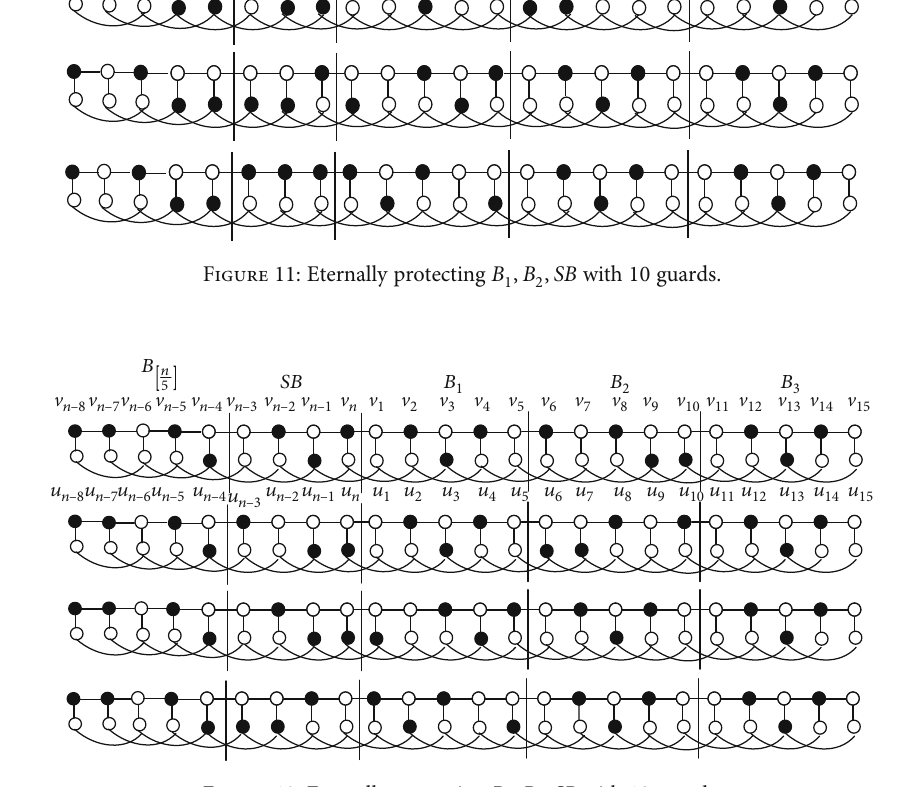
Figure 12: Eternally protecting B